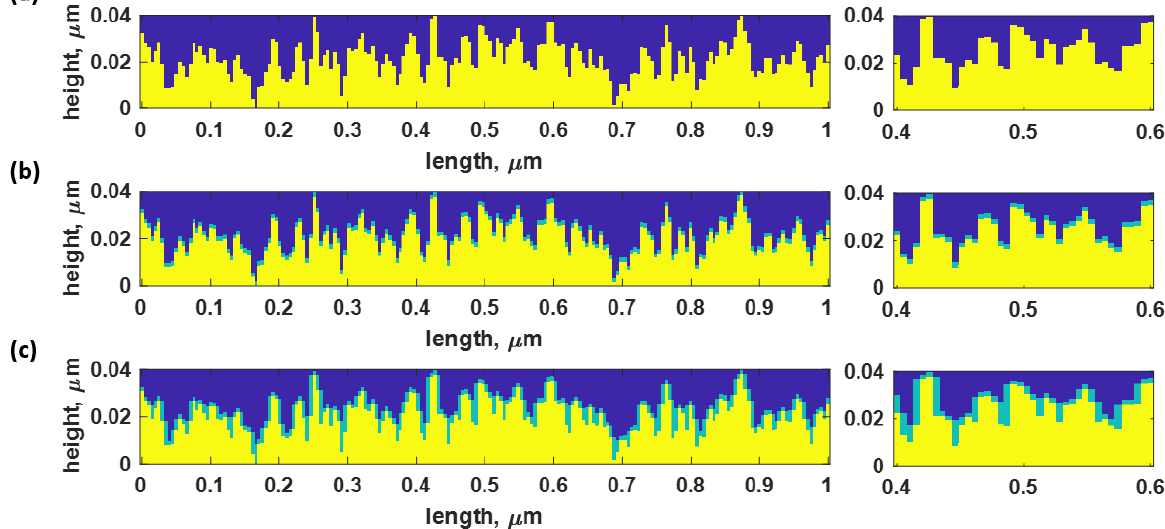
Figure 2. The Gaussian random rough surface for h 20 nm of and cl of 5 nm for ( a ) no BSA protein coating case (bare gold case), ( b ) BSA protein without sidewall coating, and ( c ) BSA protein with sidewall coating. The figures on the right show the zoomed-in version of rough surfaces for the three models.